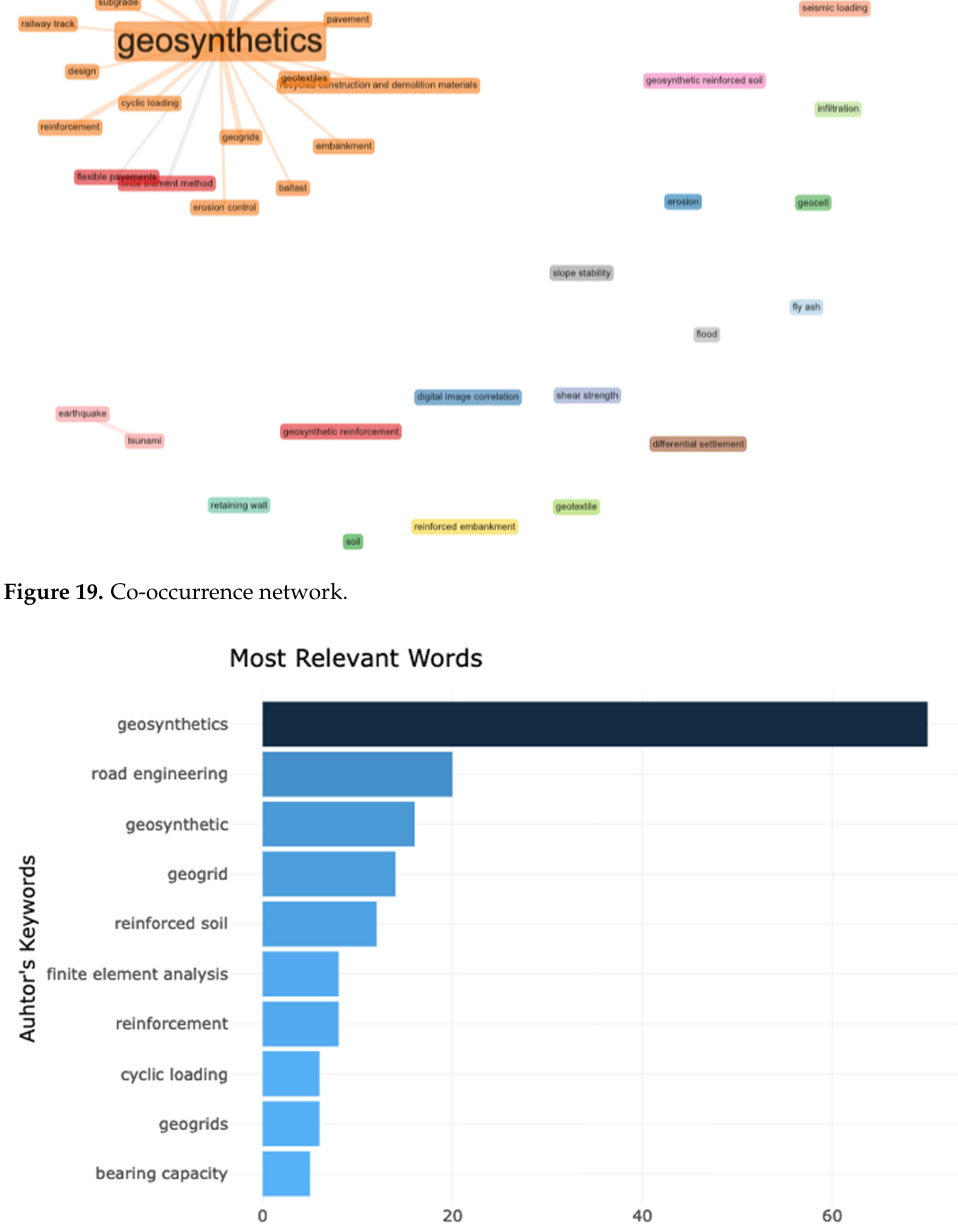
Figure 20. Word occurrences.